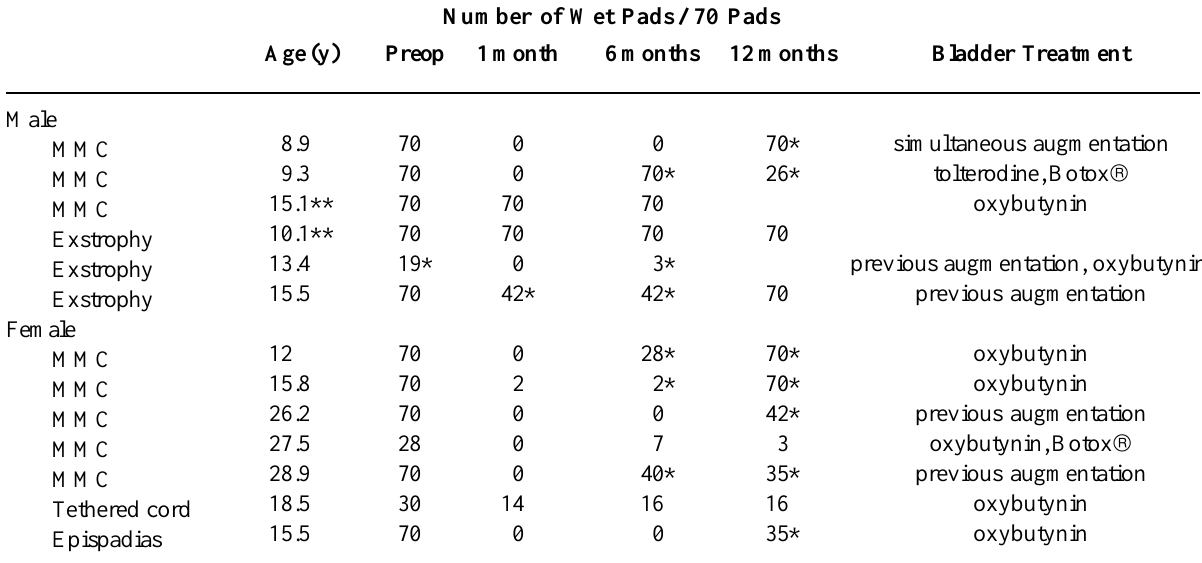
Table 1 – Patients with Pelvilace  sling procedure and the number of wet pads during last 2 weeks at preoperative period as well as at 1, 6 and 12 months postoperatively. All the patients have clean intermittent catheterizations 5 times a day and used 70 pads during 2